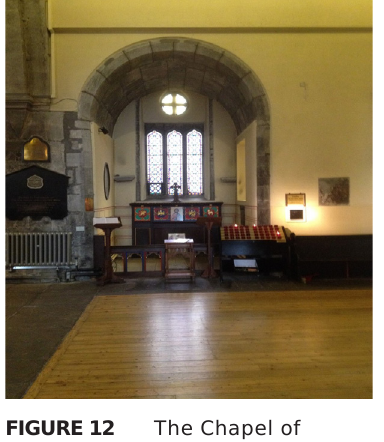
Christ, in the south transept.